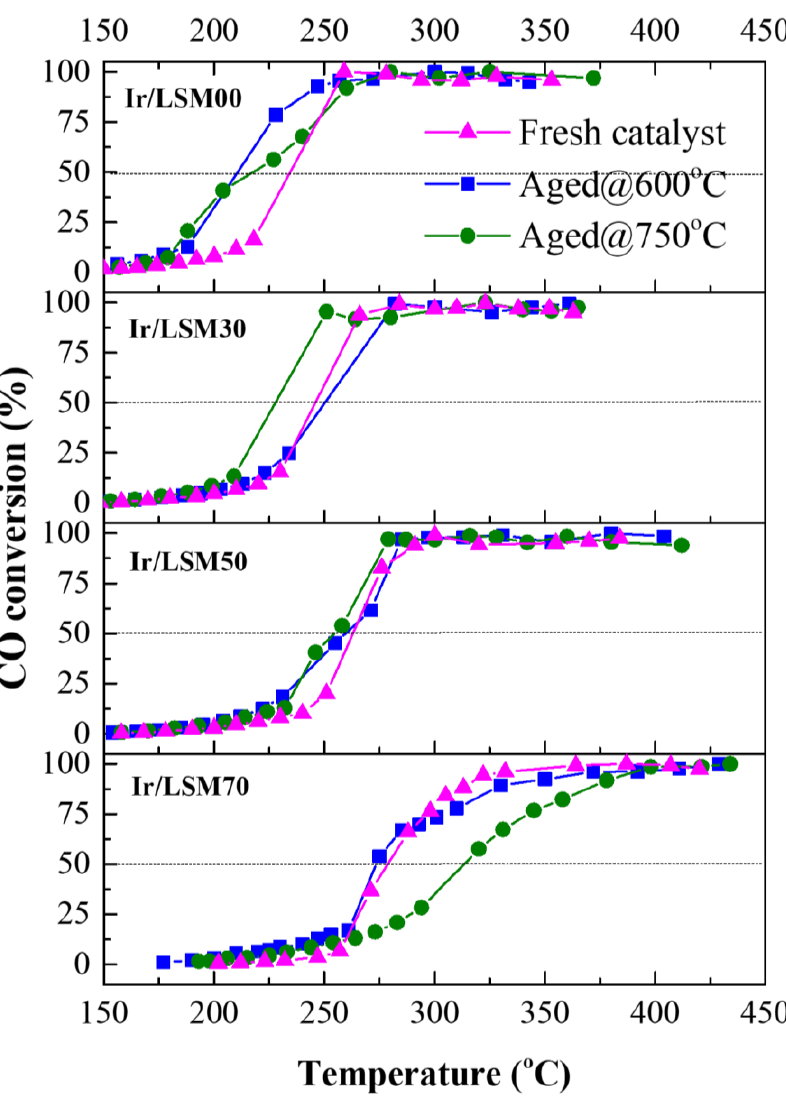
Figure 8. CO conversion profiles over fresh, Aged@600 ◦ C and Aged@750 ◦ C Ir/LSMx catalysts. Experimental conditions: 1.0% CO, 5.0% O 2 , He balance at 1 bar; FT = 160 mL/min, catalyst mass mcat = 20 mg, wGHSV = 480,000 mL/g∙h.